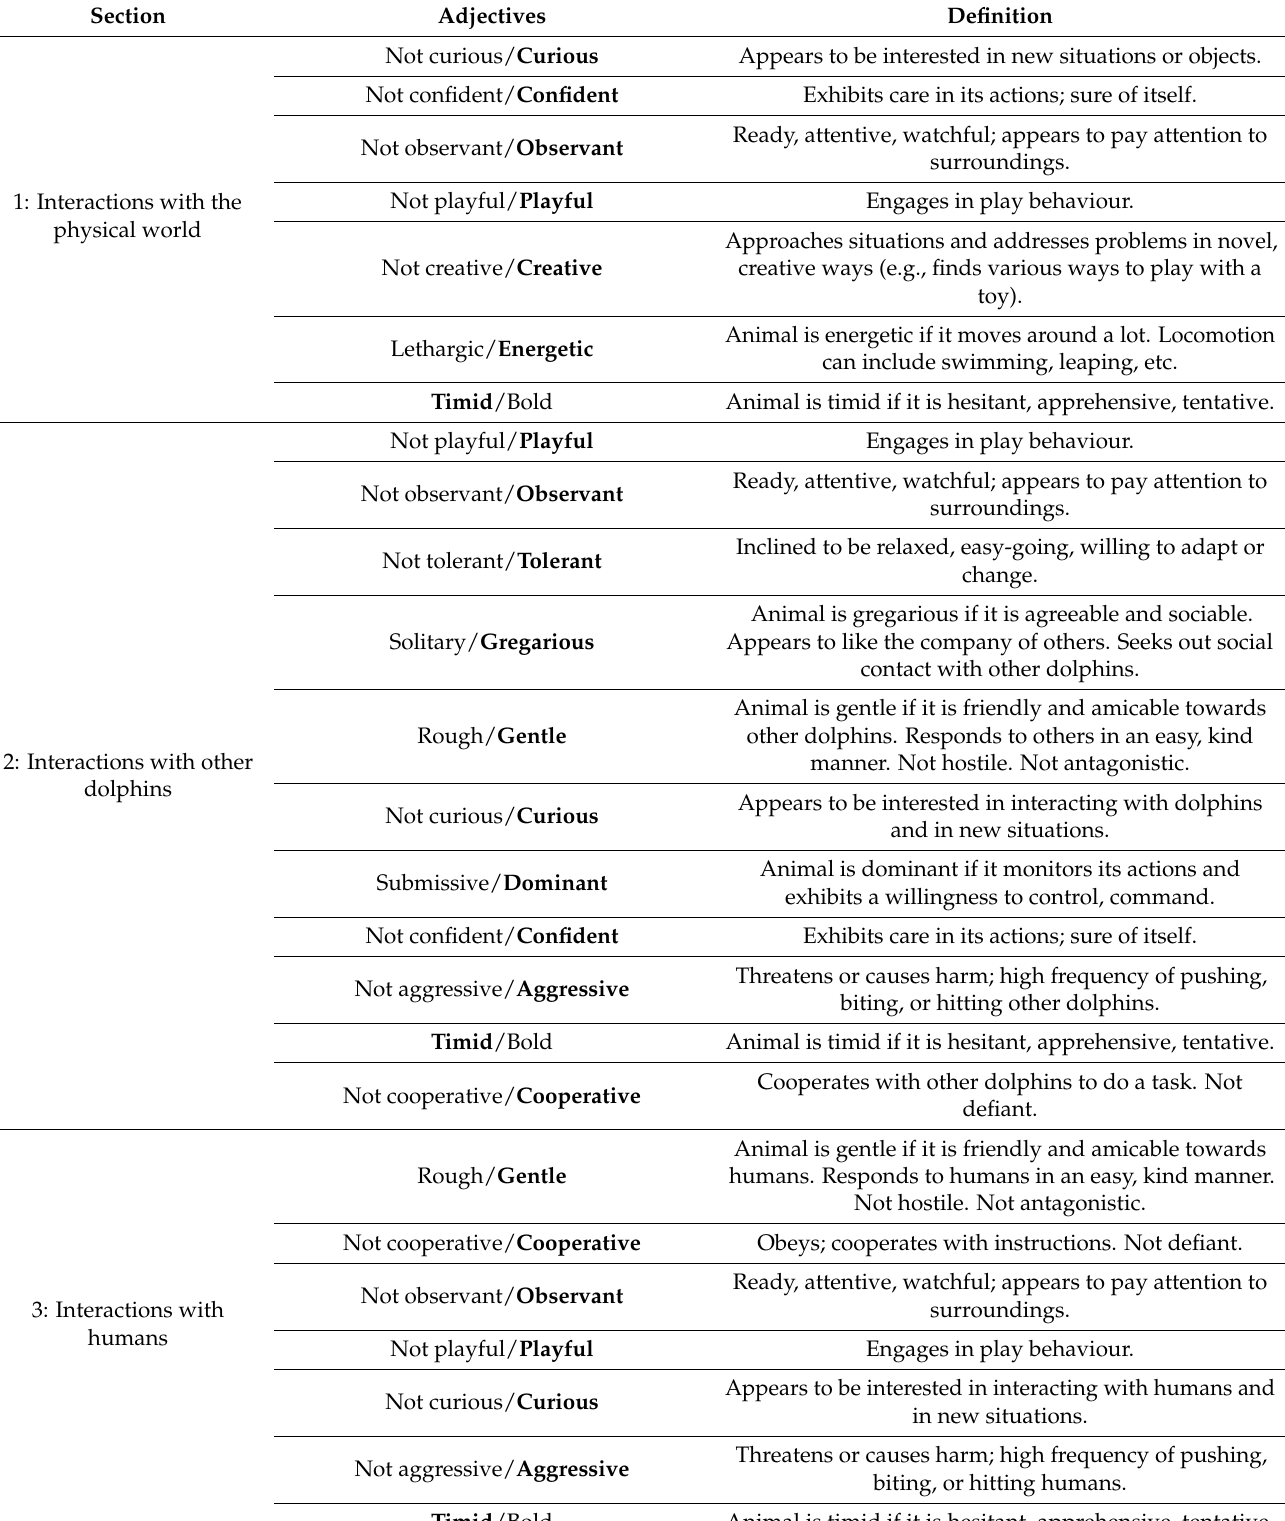
Table 1. List of adjectives and their meanings considered for each of the three sections included in the personality questionnaire (based on Highfill et al. [23] and Kuczaj et al. [24]). The terms in bold will be used as the baseline